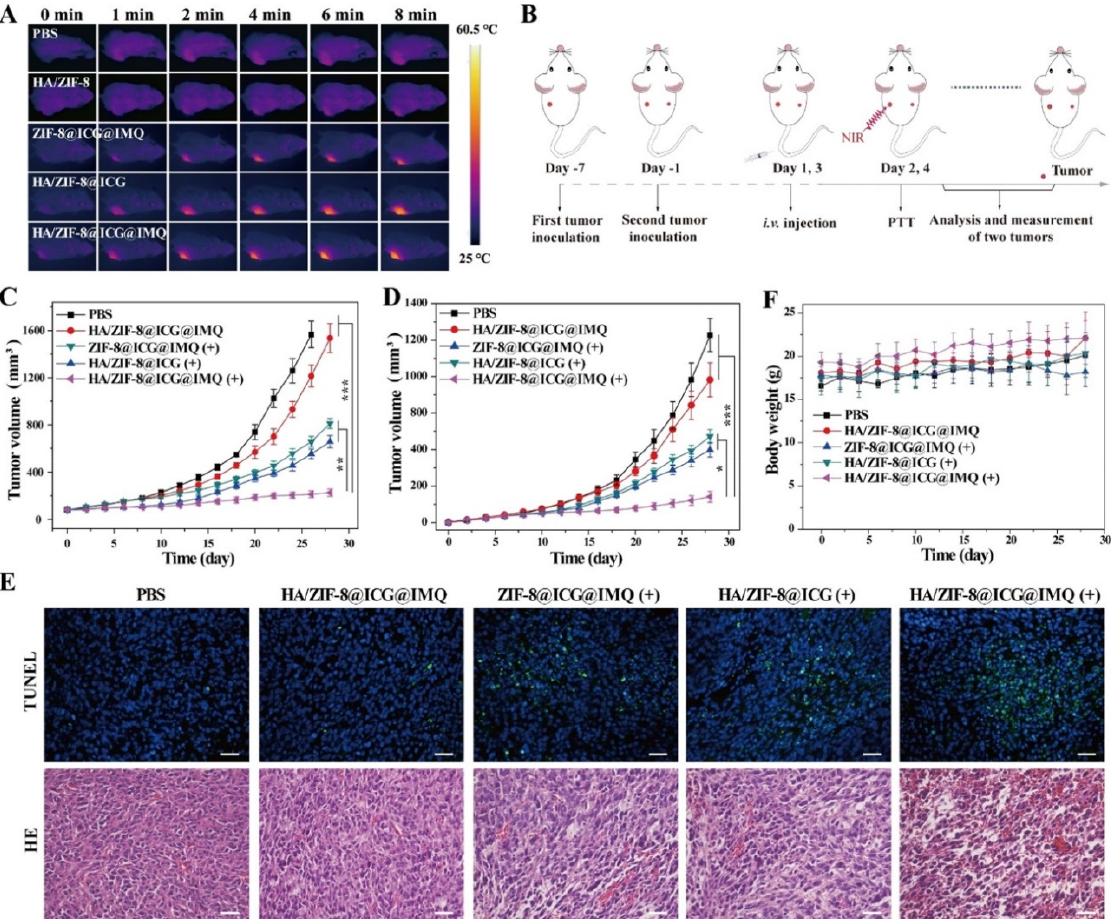
Figure 4. Immuno-PTT mediated by HA-coated MOF-loaded with ICG and R837. ( A ) Mice’s thermal images after NIR irradiation of the primary tumor; ( B ) Schematic representation of the immuno-PTT treatment; ( C ) Primary and ( D ) Secondary tumor volumes after the different treatments; ( E ) TUNEL and hematoxylin and eosin (HE) staining of primary tumor’s slices; Scale bar, 50 μ m. ( F ) Mice’s body weight. Reprinted with permission from [108]. Copyright 2020 American Chemical Society. HA/ZIF-8: HA functionalized Zeolitic Imidazolate Framework-8 (ZIF-8) nanoparticles/HA-